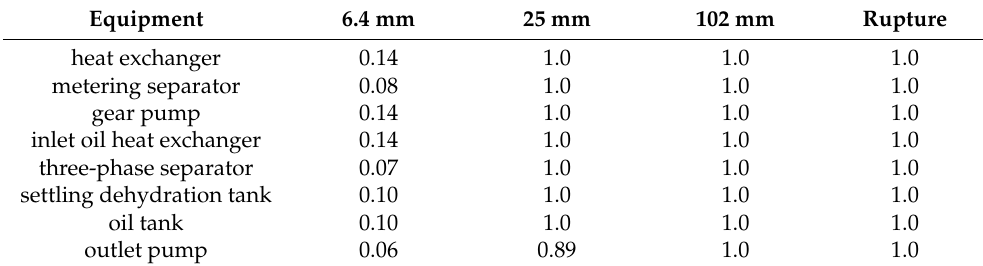
Table 9. Mix coefficient f act IC n of equipment.